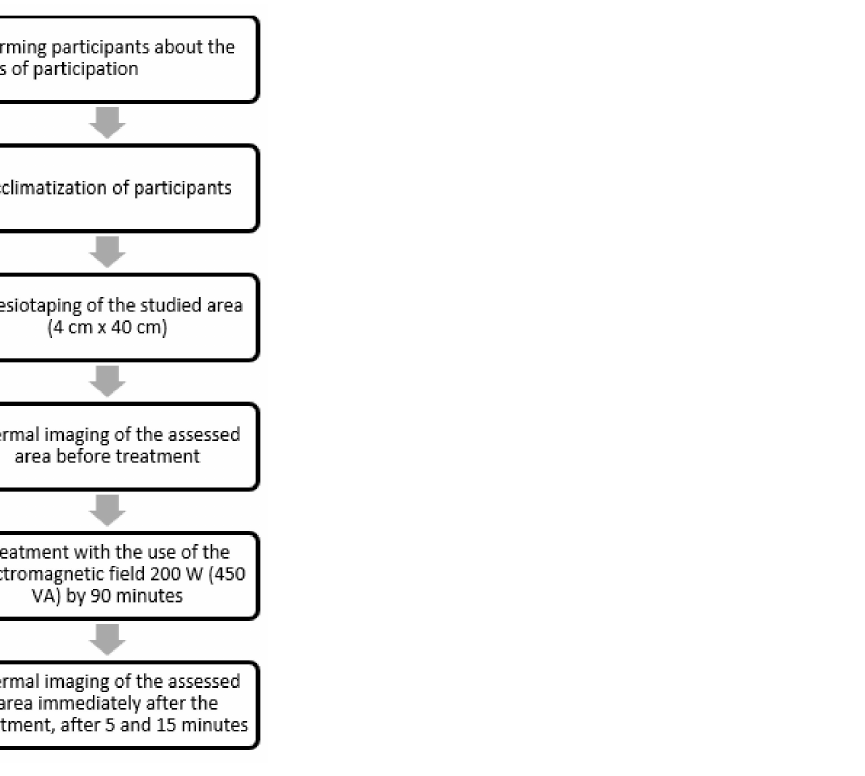
Figure 3. Procedure for the use of high-frequency electromagnetic field and thermal imaging of the area under